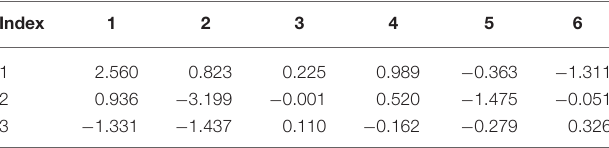
TABLE 9 | Internal strain tensor (Voigt notation) of N 2 for displacements in x, y, z (eV/Å).